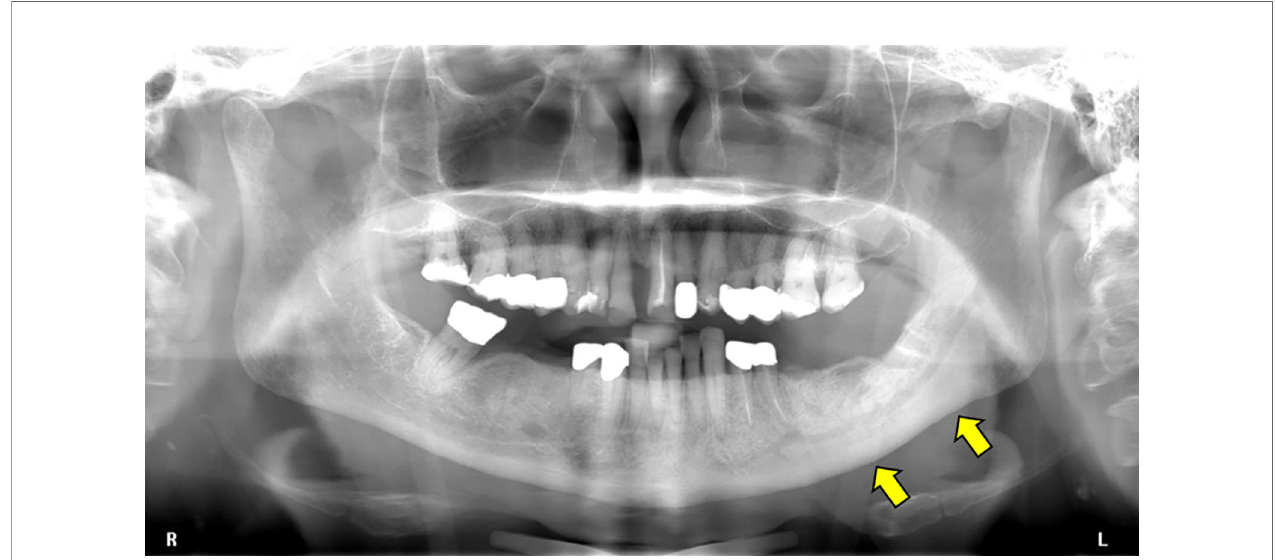
FIGURE 2 | Panoramic radiograph showing sclerosis of the left mandible (yellow arrows) surrounding the inferior alveolar canal. No evidence of sclerosis in the right mandible.